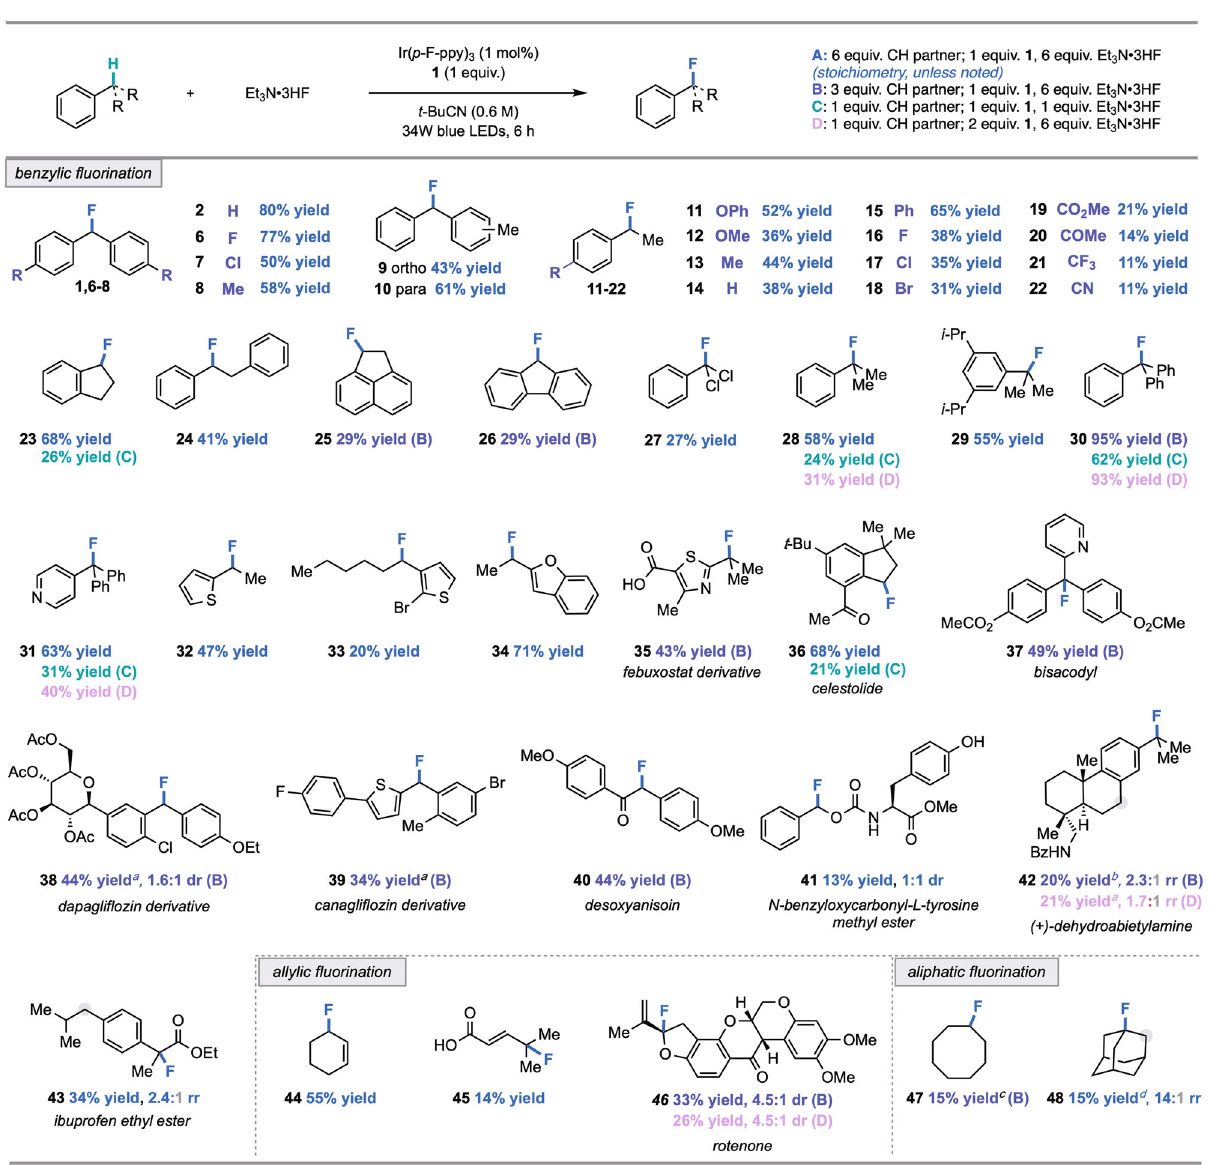
Fig. 2 Scope of C(sp 3 ) – H fl uorination (0.25 mmol scale, 19 F NMR yields). a Reaction performed using Ir( p -CF 3 -ppy) 3 as photocatalyst and benzene as solvent. b Reaction performed using Ir( p -CF 3 -ppy) 3 as photocatalyst and 1,2-di fl uorobenzene as solvent. c Reaction performed with 20 mol % n -Bu 4 NPF 6 . d Reaction performed using Ir( p -CF fl uorobenzene as solvent, and abstractor 3 3 -ppy) 3 as photocatalyst, 1,2-di